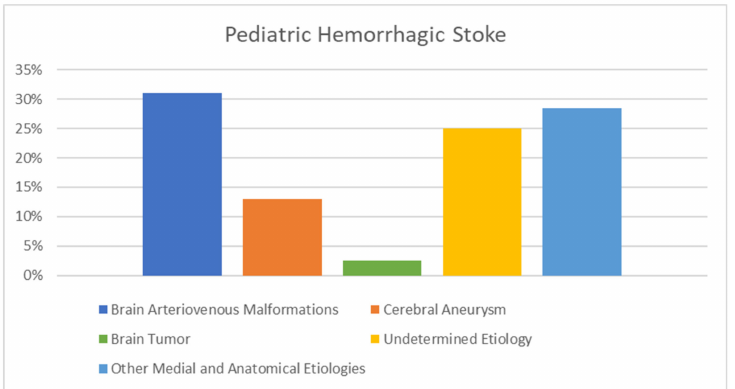
Figure 1. Graph showing the commonality of the different causes of hemorrhagic stroke in